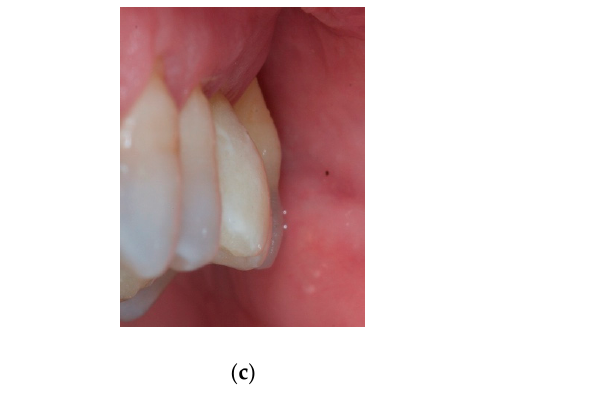
Figure 5. Intraoral view of the conditioned soft tissues after a healing period of 3 months: ( a ) occlusal view of the augmented peri-implant soft tissues shaped according to the emergence profile of the temporary crown. ( b ) Occlusal view of the augmented volume with the temporary crown in situ. ( c ) Buccal view of the augmented volume with the temporary crown in situ.